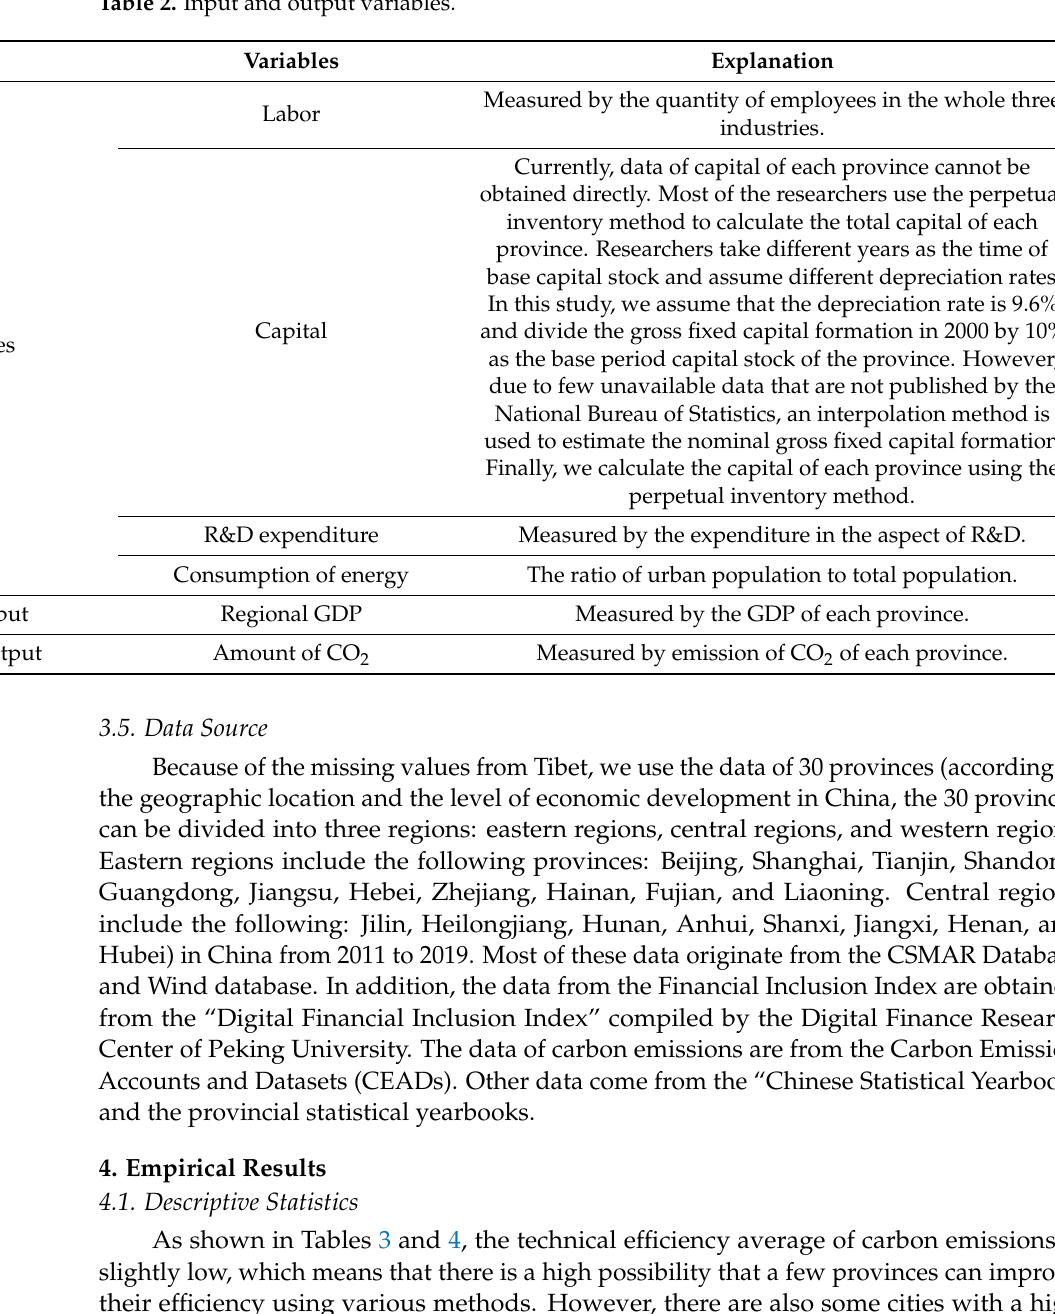
Table 2. Input and output